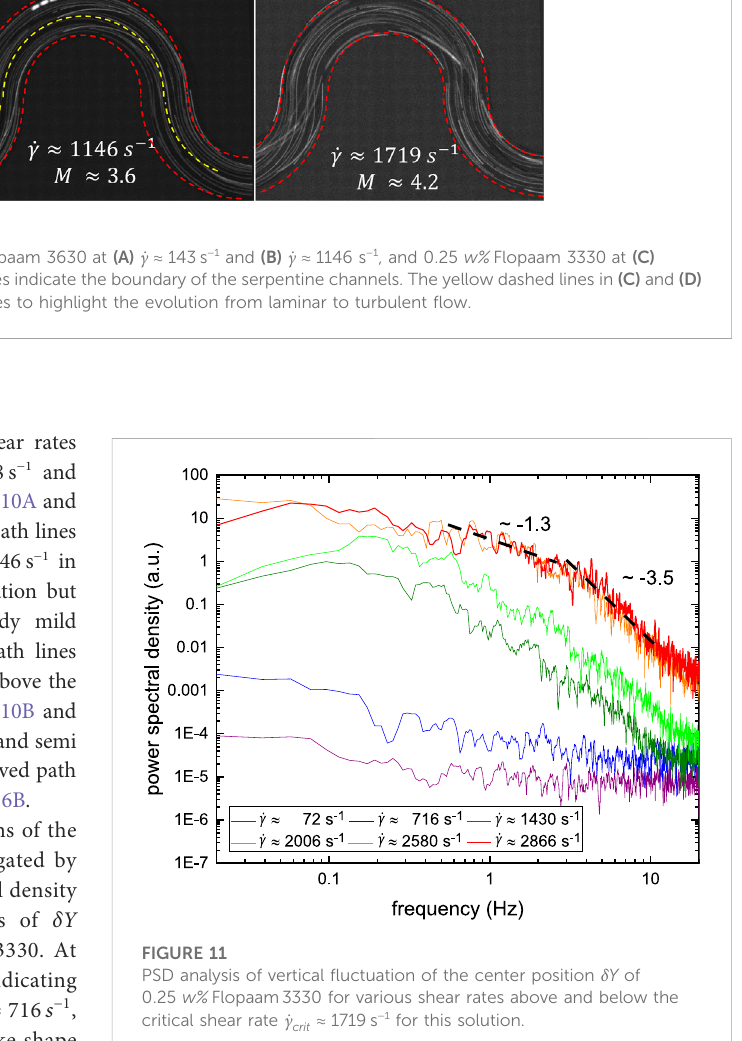
FIGURE 11 PSD analysis of vertical fl uctuation of the center position δ Y of 0.25 w% Flopaam3330 for various shear rates above and below the critical shear rate _ γ crit ≈ 1719s − 1 for this